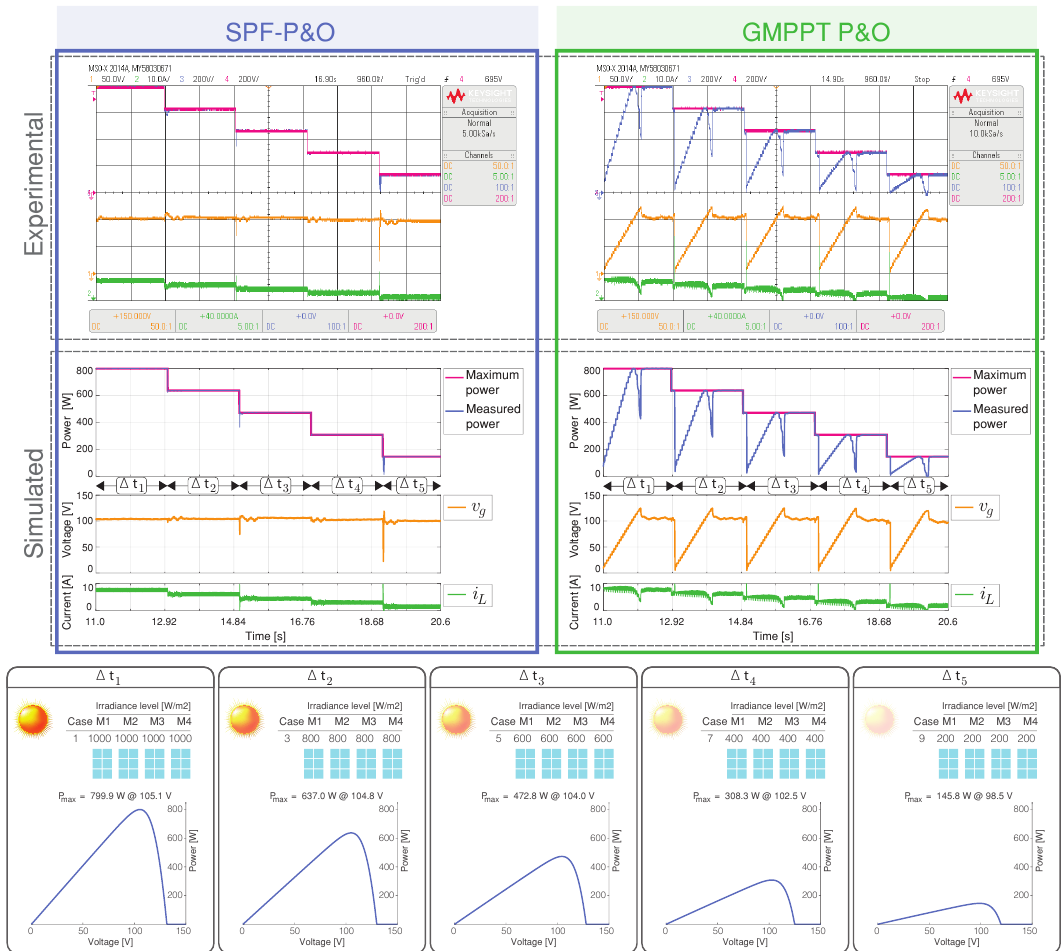
Figure 7. Simulated and experimental dynamic behavior of the MPPT algorithms for Scenario 2 with an output voltage V o = 160 V. The proposed MPPT algorithm (right) is compared with the GMPPT P&O algorithm (right). CH1: v g (50 V/div), CH2: i L (10 A/div), CH3: Maximum power (200 W/div), CH4: Measured power (200 W/div) and a time base of 960